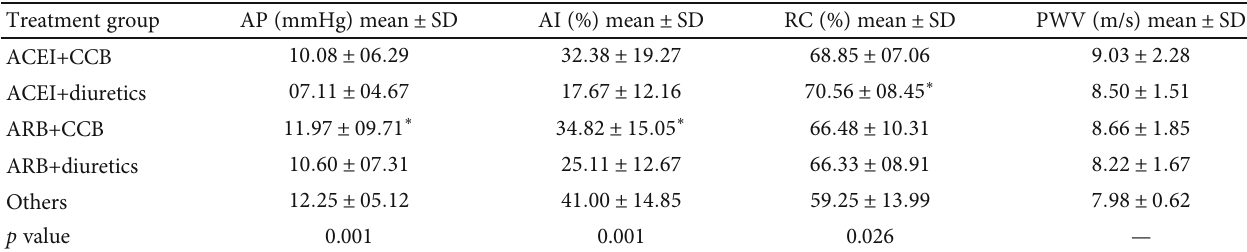
Table 6: Measurement of arterial sti ff ness.